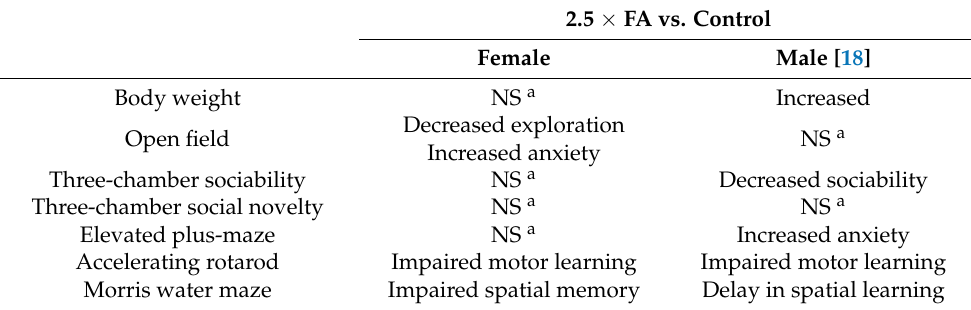
Table 4. Summary of body weight changes and behavioral results of 2.5 × FA female and male mice. 2.5 × FA vs.